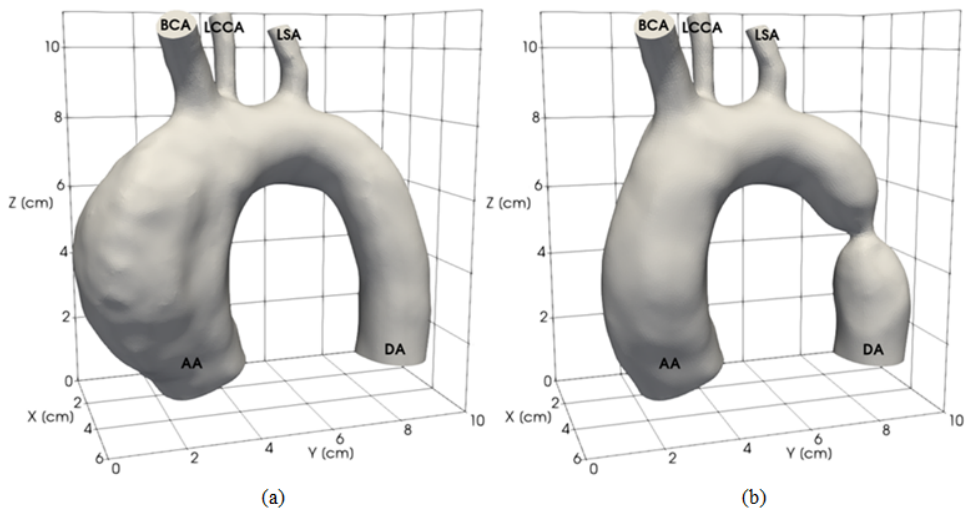
Figure 2. Geometries ( a ) of the aneurysmatic aorta and ( b ) of the coarctated aorta.